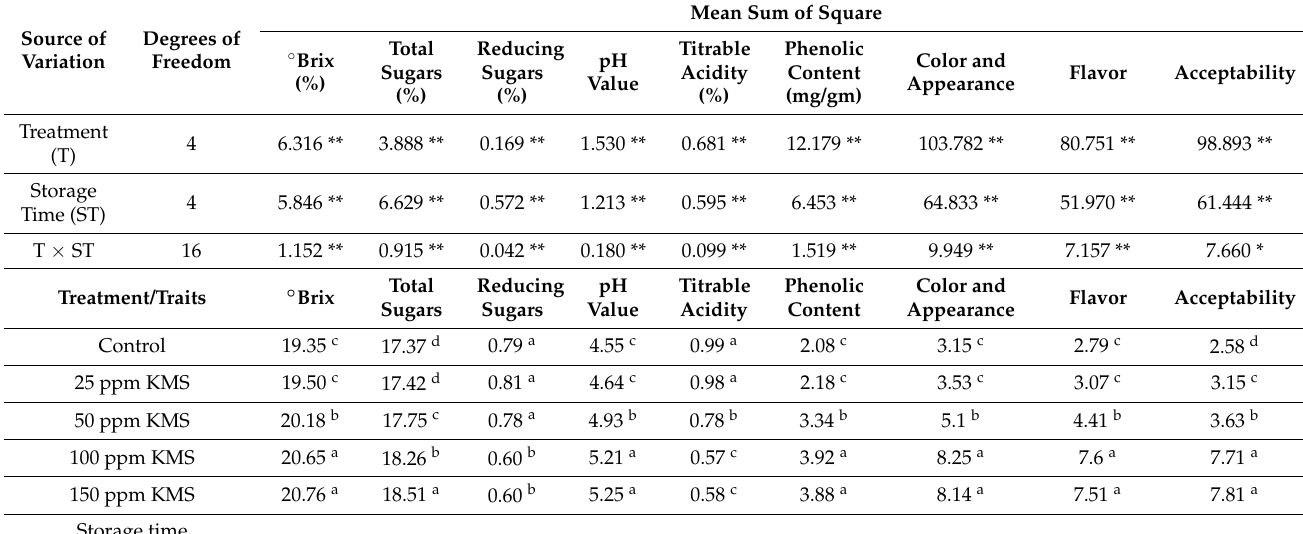
Table 2. Two-way ANOVA showing the effect of sulphitation on the physico-chemical properties and sensory evaluation at different storage intervals of sugarcane